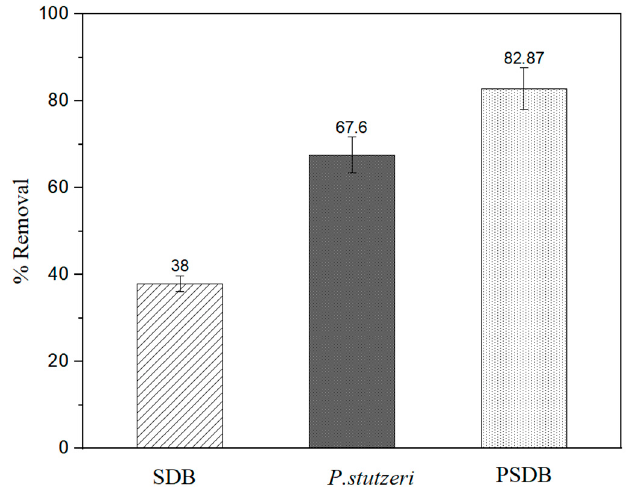
Figure 11. Comparative plot of Ni 2+ removal efficiency by SDB, Pseudomonas stutzeri , and PSDB.